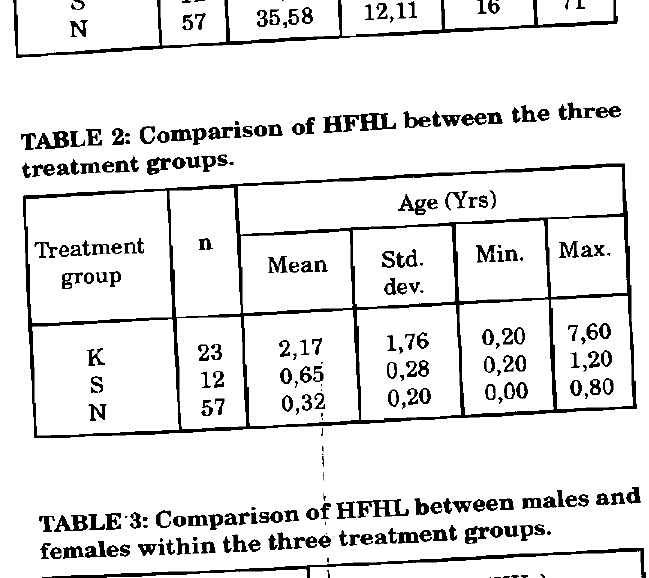
TABLE* Comparison ol HFffl· b e . » * » « Λ» ϋ treatment